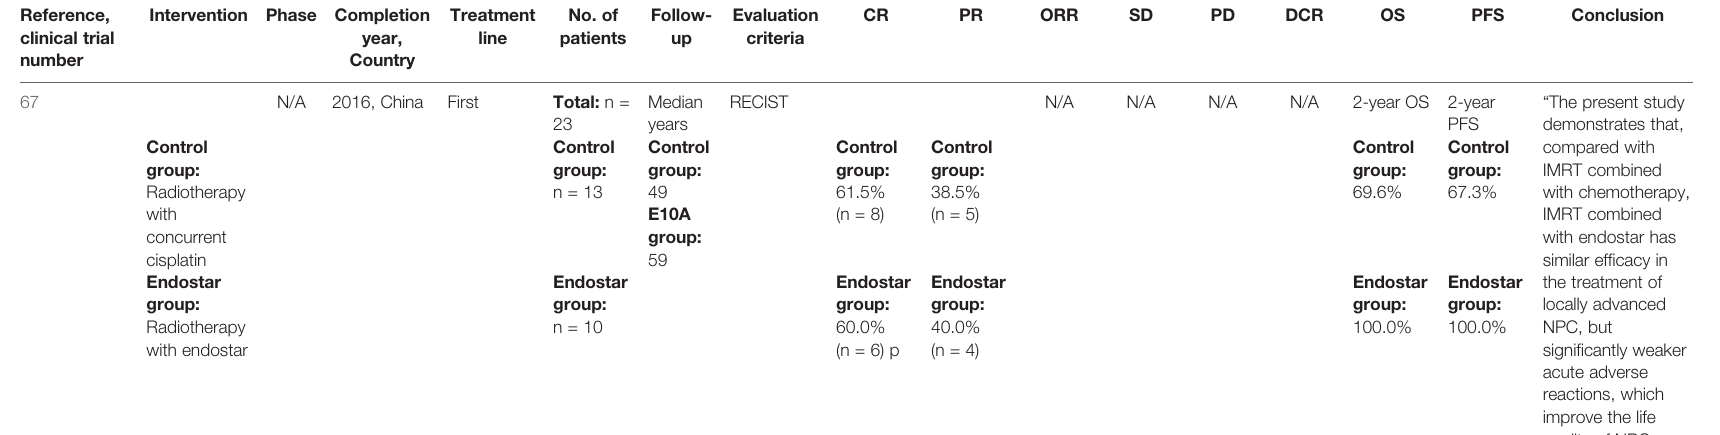
TABLE 5 | Summary of the endostatin clinical trials for head and neck squamous cell carcinoma. Reference, clinical